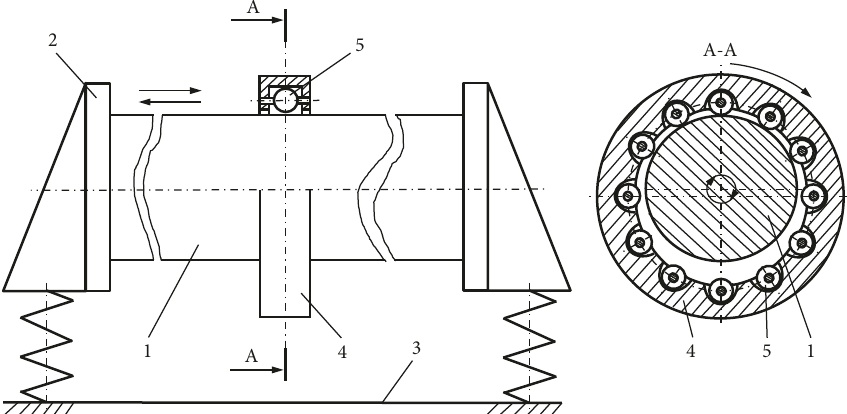
Figure 1: Scheme of V SO of external cylindrical surfaces: (1) sample; (2) brackets; (3) the common platform; (4) tool; (5)